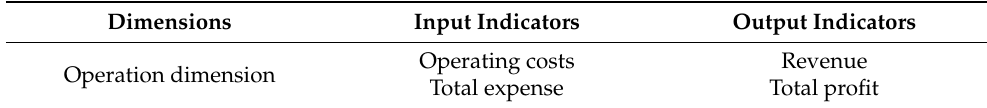
Table 1. Operation dimension evaluation index system.